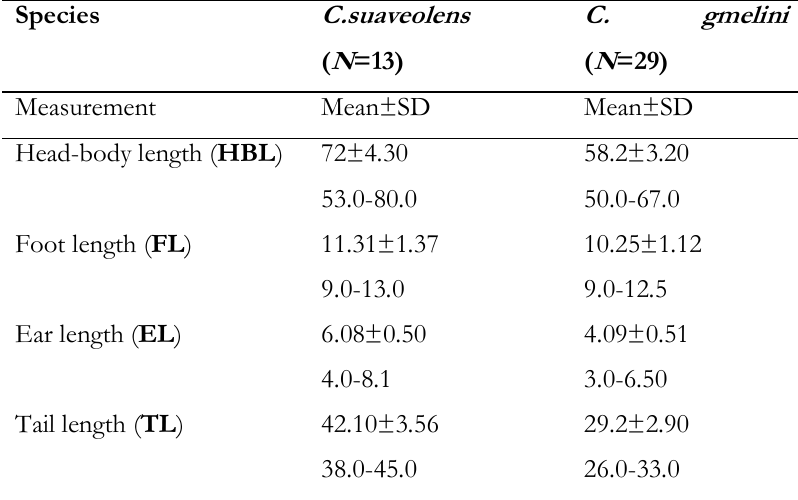
Table 2. Means (±SD) and range of external measurements (mm) of Crocidura gmelini and C. suaveolens from